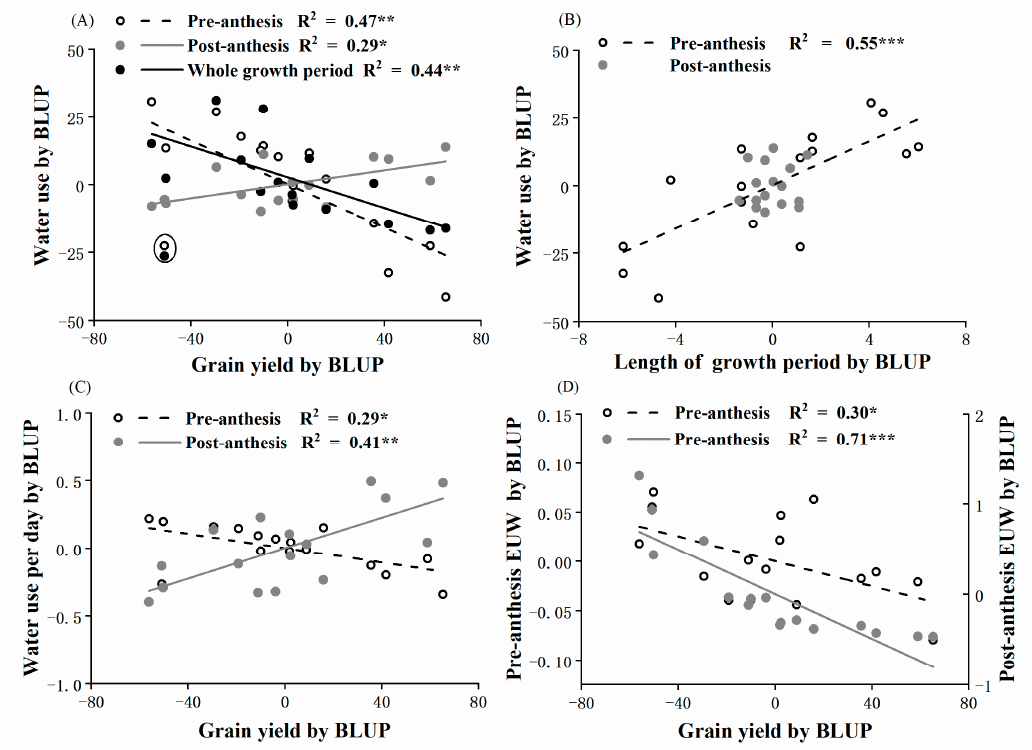
Figure 4. The relationships between ( A ) grain yield by BLUP and water use by BLUP; ( B ) length of the growth period by BLUP and water use by BLUP; ( C ) grain yield by BLUP and daily water use by BLUP; ( D ) grain yield by BLUP and effective use of water (EUW) by BLUP over different growth stages. Only the significant linear regressions are shown. The circled genotype in ( A ) is 021-128, which was not included in the linear regression (see text). * p < 0.05; ** p < 0.01; *** p < 0.001. Note change of scale of y-axis for pre- and post-anthesis EUW in Figure 4D.